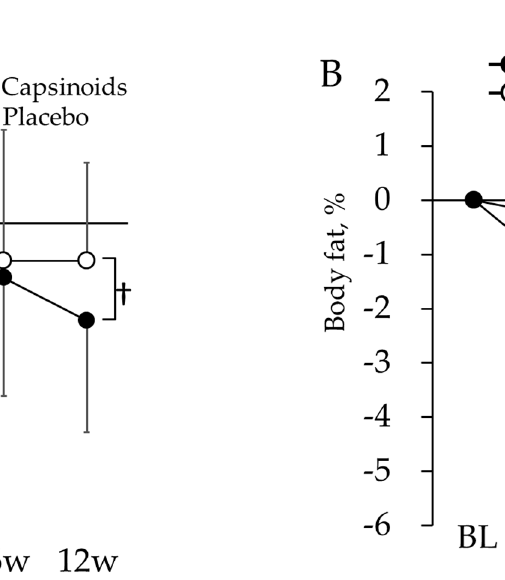
Figure 3. Changes in body fat from BL in all subjects ( A ) and overweight subjects ( B ). The values are the differences from baseline value. The error bars represent standard deviation. Body fat in capsinoids group was lower than placebo group at the 12th week († p < 0.05). In overweight subjects, it also showed significant change in capsinoids group compared with placebo group at the 12th week (* p < 0.05).